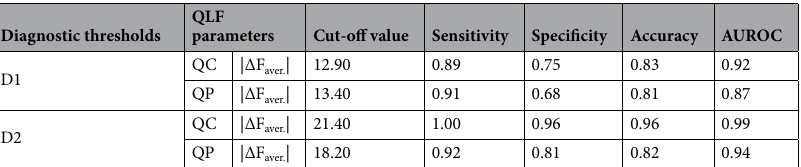
Table 2. Cut-off values and validity of QLF parameters for detecting occlusal dental caries. Quantitative light- induced fluorescence (QLF), Qraycam Pro® (QP), Qraypen C®